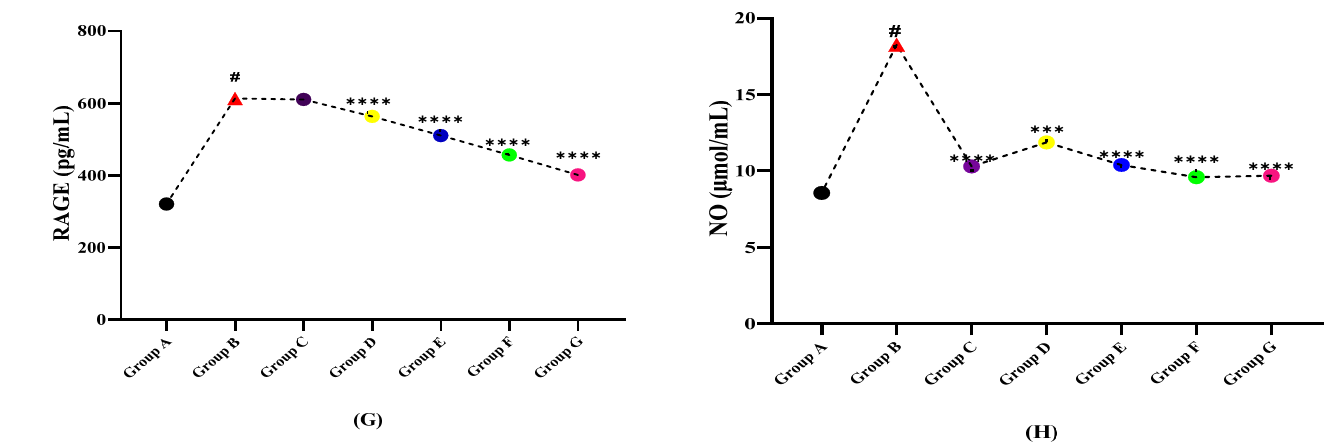
Figure 3. Comparison of plant extracts treated groups independently against LPS induced multiple sclerotic Wistar rats ( A ) SOD, ( B ) CAT, ( C ) GSH, ( D ) GPx, ( E ) AOPPs, ( F ) AGEs ( G ) RAGE, and ( H ) NO. (# indicate reference group EAE model while Asterisks are showing the significance in the improvement of results as compared to reference group B). (*) slight significance, (**) moderate significance, (***) high significance, (****) very highly/effective significance. Table 4. DNA Damage Profile Of LPS Induced Multiple Sclerotic Wistar